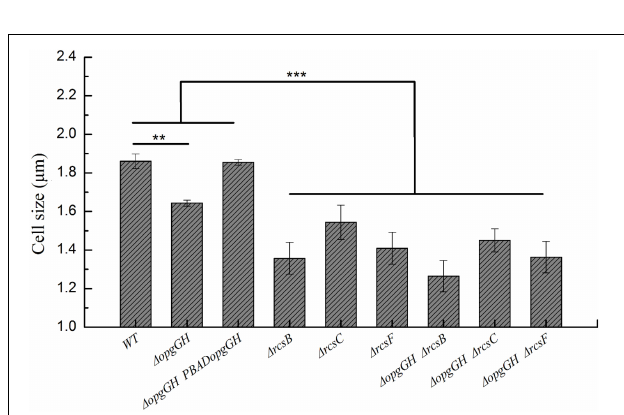
FIGURE 6 | Changes in the cell size of wild-type and mutant strains. Bacteria were grown to the mid-log phase in LNNS medium supplemented with 0.6 g/L L -arabinose and cell size was measured using transmission electron microscopy. The data are presented as the mean ± SD of at least three independent experiments. An asterisk indicates a significant difference with *** P < 0.001, ** P < 0.01.